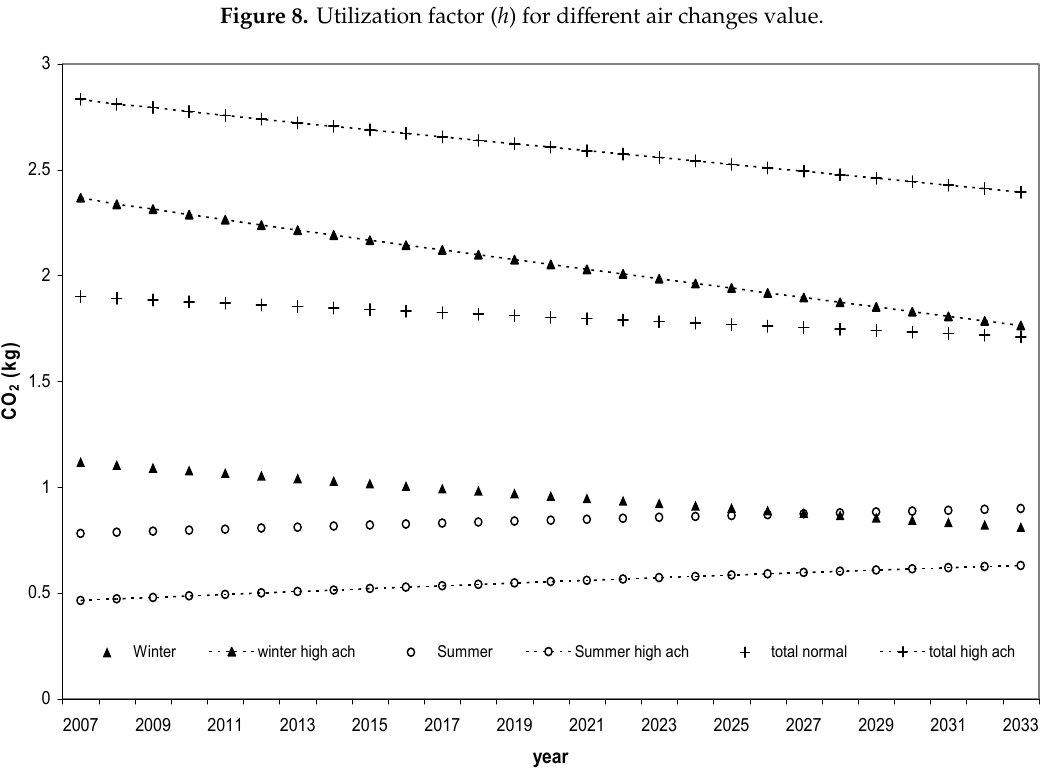
Figure 9. Predicted seasonal carbon dioxide emissions respect temperature and ach increment in the next years in the northwest of Spain.